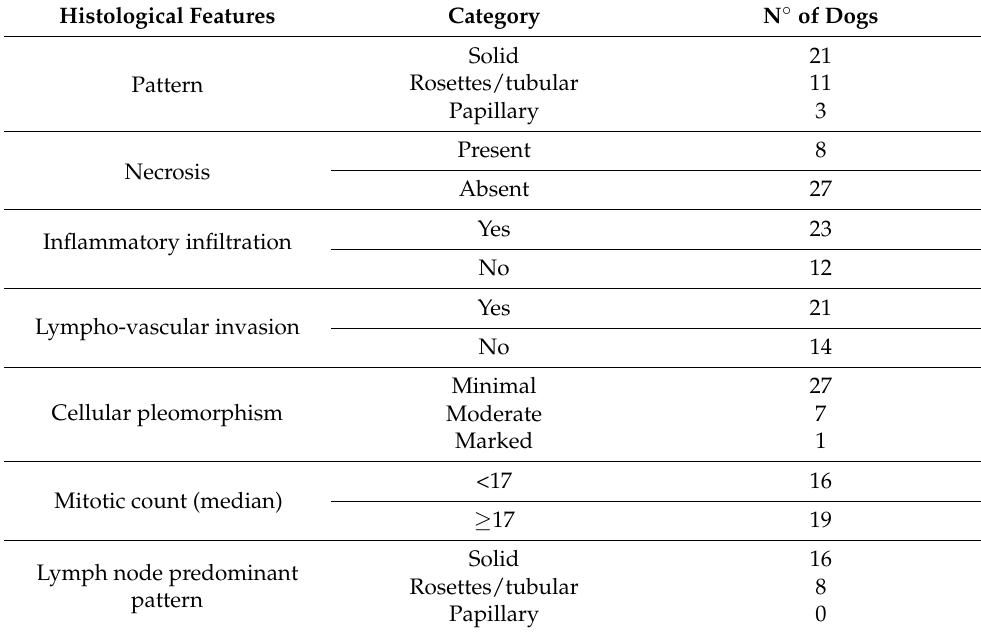
Table 3. Histological features of the AGASACA